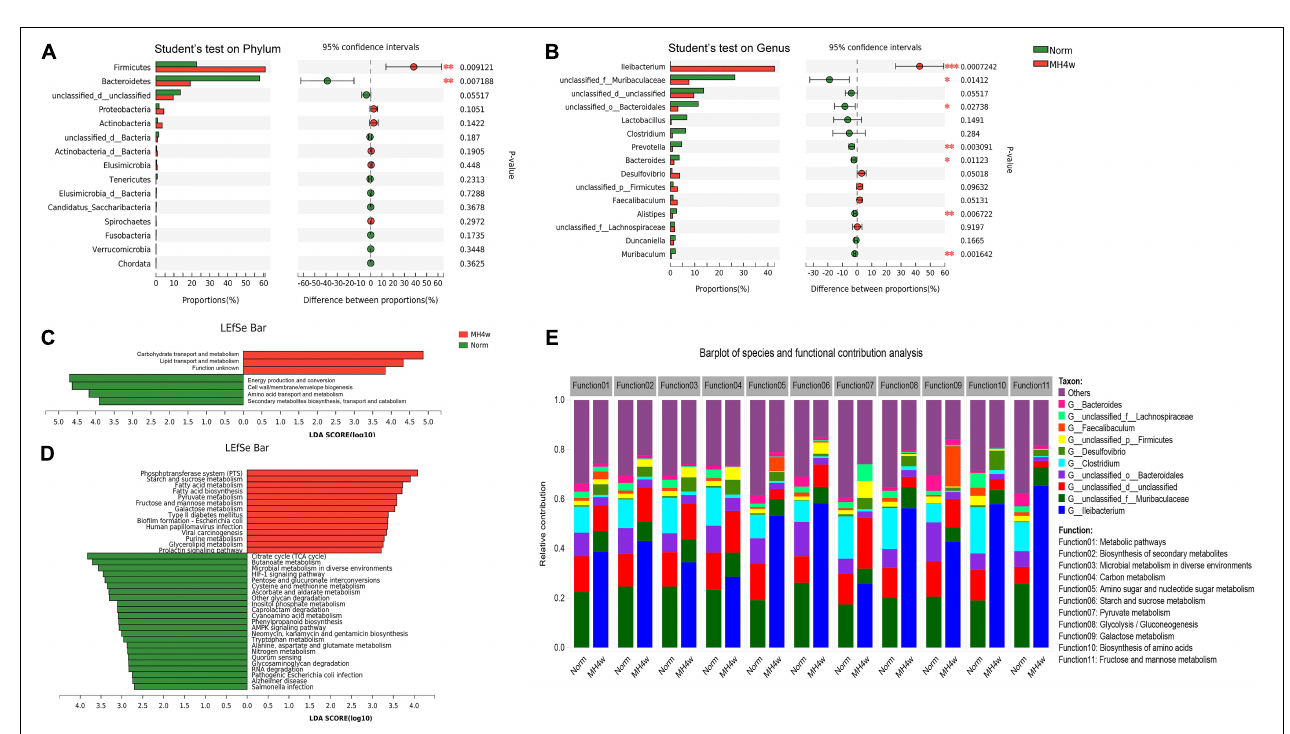
FIGURE 4 | Statistical comparison of relative abundances of dominant microbial phyla (A) and genera (B) under normoxia and MH4w groups. Linear discriminant analysis (LDA) integrated with effect size (LEfSe) analysis of a cluster of orthologous groups of proteins (COG) (C) and the Kyoto Encyclopedia of Genes and Genomes (KEGG) (D) pathways between normoxia and MH4w groups (LDA score > 2.5, P < 0.05). (E) Relative contribution to carbohydrate metabolic pathways (top 11 in level 3) within the bacterial communities (top 10). Statistical symbols: ∗ P < 0.05, ∗∗ P < 0.01, and ∗∗∗ P < 0.001.